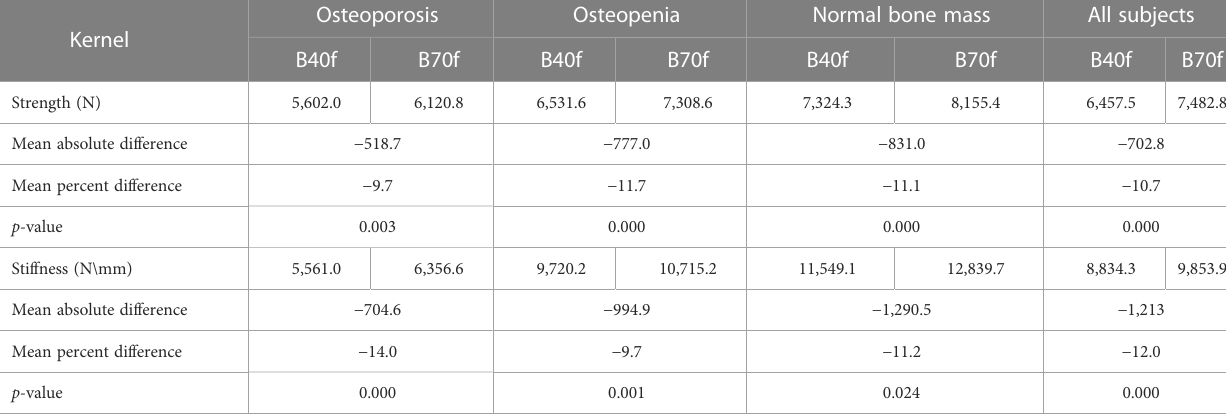
TABLE 1 Estimated vertebral strength and stiffness by FEA based on standard and bone reconstruction kernels.